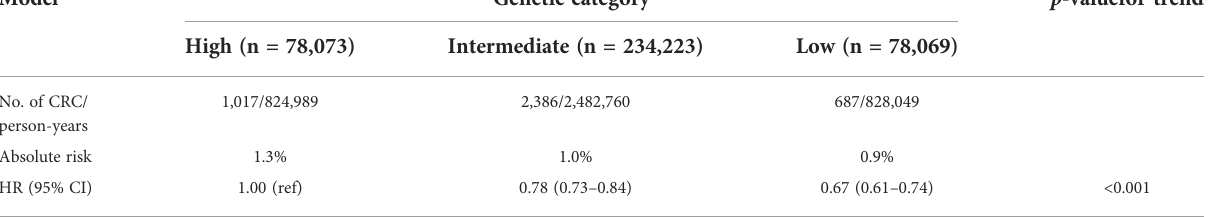
CRC, colorectal cancer; HR, hazard ratio; CI, con fi dence interval. Cox proportional hazards regression adjusted for age, sex, education, Townsend deprivation index, fi rst 10 genetic principal components, and healthy lifestyle scores. p-value for trend was modeling the lifestyle categories as a continuous